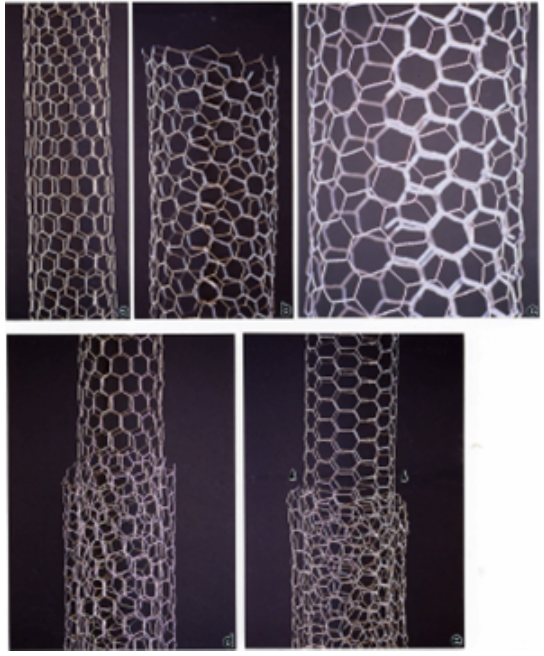
Figure 13: Simple chicken wire models of carbon nanotubes. (a) Zig-zag type single wall. (b) Chiral tube. (c) Magnified view of (b). (d) Chiral tube growing over the zig-zag tube in (a). (e) Chiral tube growing over an arm-chair type tube. Arrows indicate growth